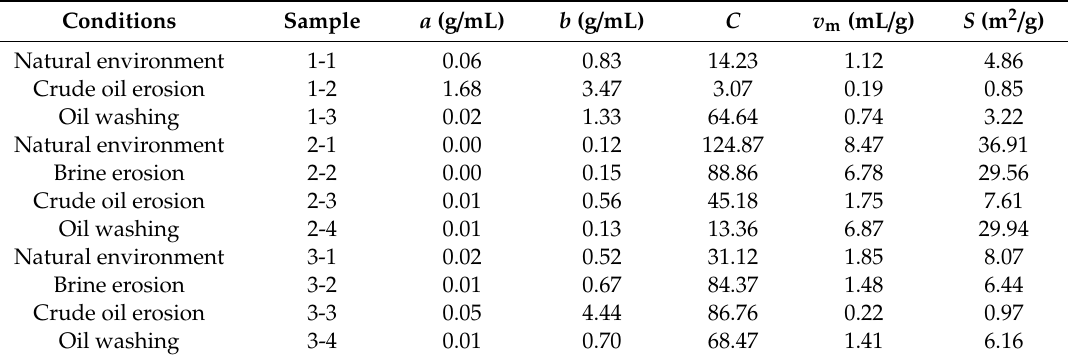
Table 7. The BET data of samples tested after treatment under three di ff erent